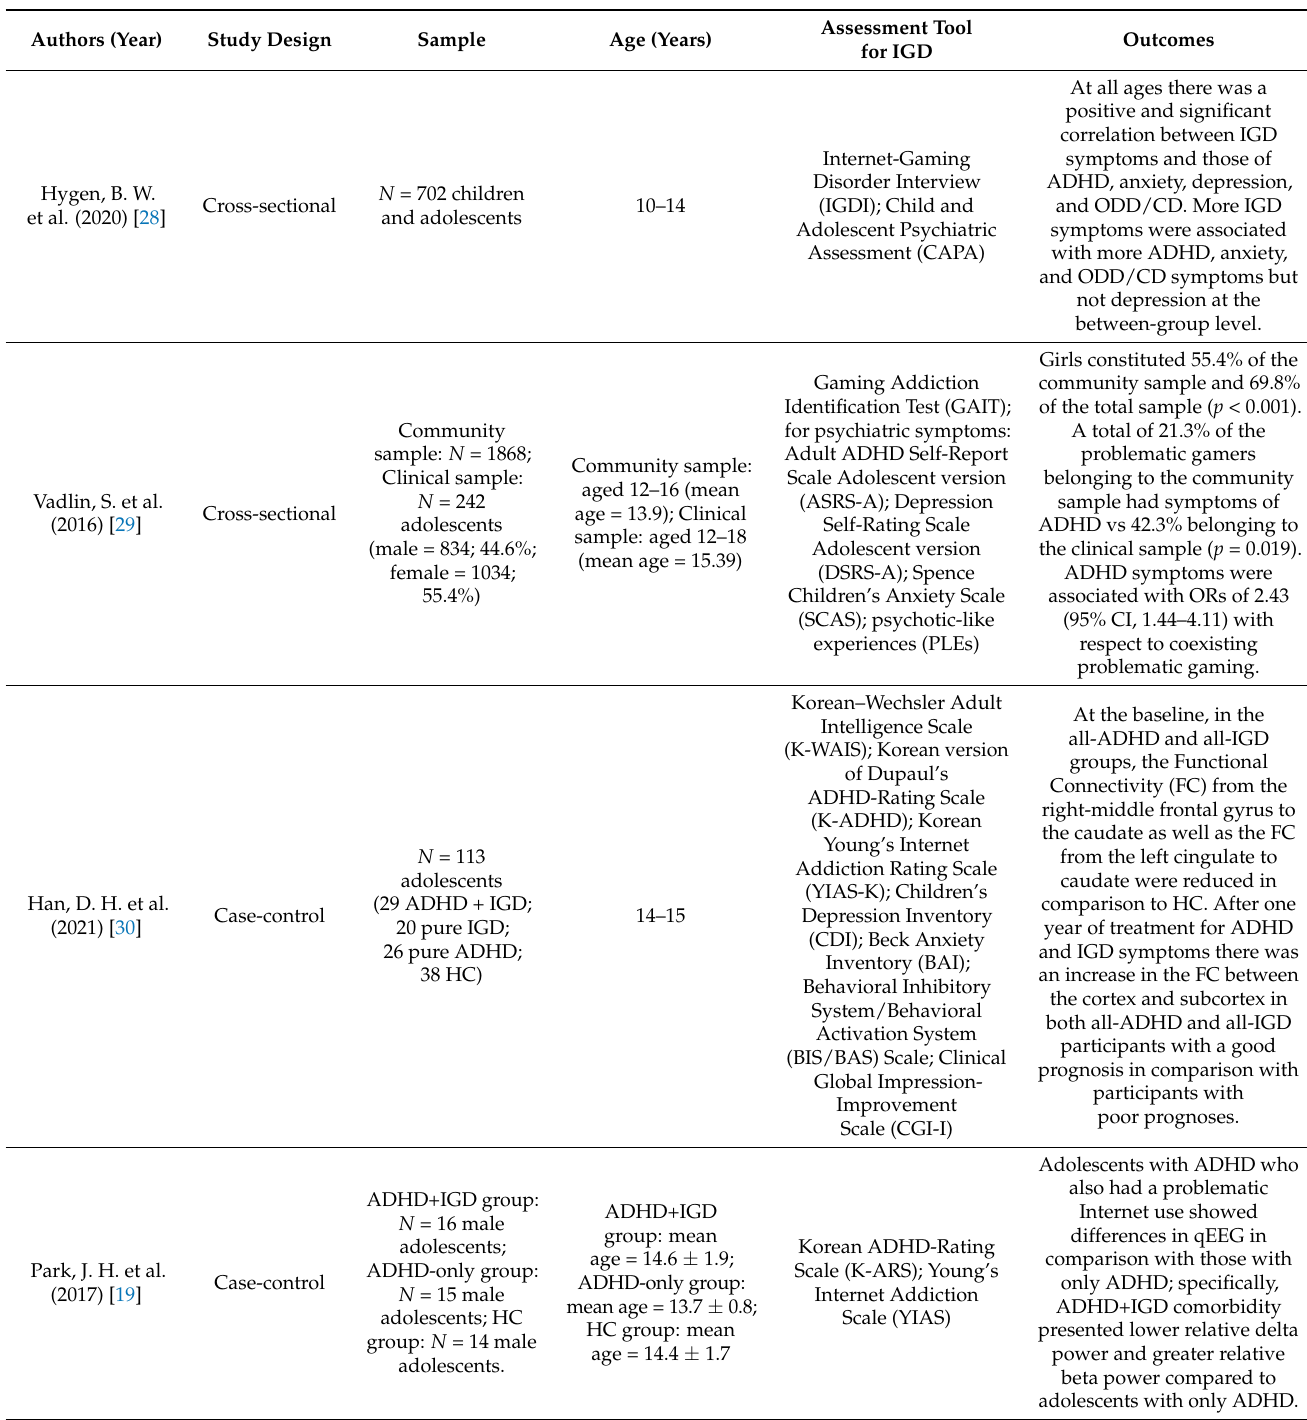
Table 1. The table displays study characteristics, design, and outcome of the studies that were found relevant to the aim of our